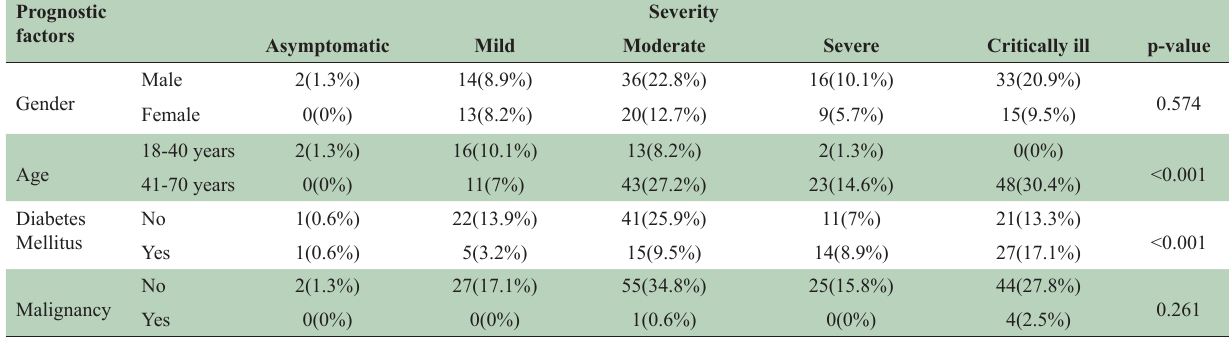
Table-III: Association between prognostic factors and Severity of COVID-19.